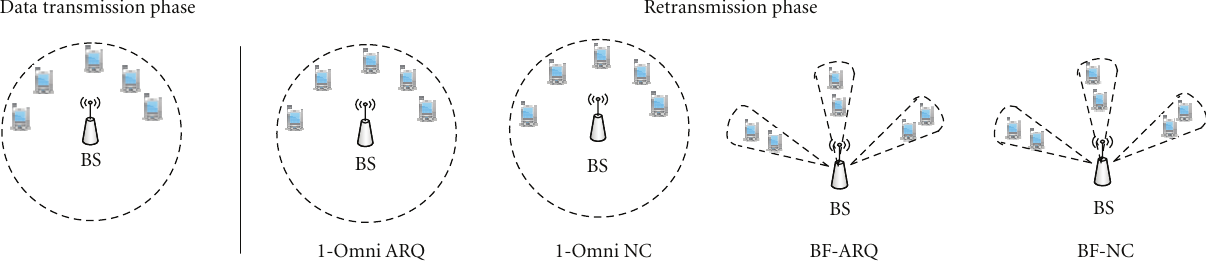
Figure 6: Broadcast transmission/retransmission schemes.